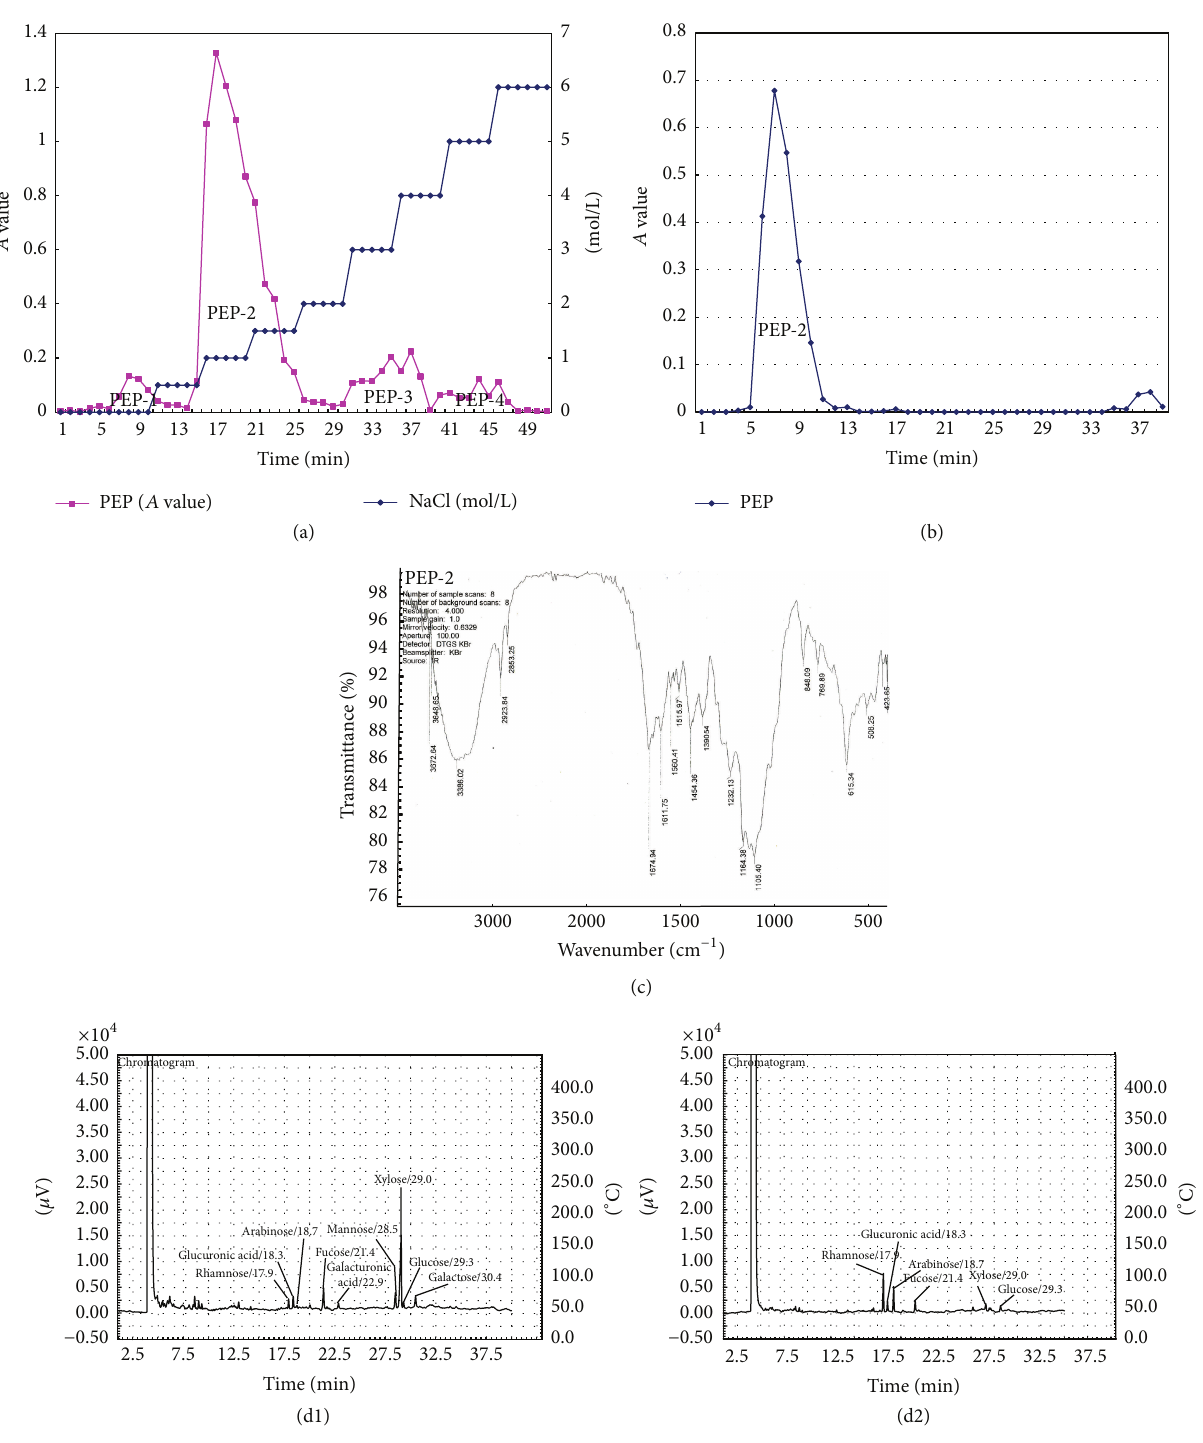
Figure 1: Characterization of polysaccharides from Enteromorpha prolifera . (a) shows four peaks in the eluting curve, PEP-1, PEP-2, PEP-3, and PEP-4. The peak area of PEP-2 is the largest and contains 161mg of polysaccharides. (b) shows the basic graph of PEP-2, which has a single, symmetrical elution peak. (c) shows the wavenumbers of 3386.02 cm −1 as the stretching vibration of O – H, 2923.84 cm −1 , 2853.28 cm −1 , and 1454.36 cm −1 as the vibration of – CH2 – . The 1390.54 cm −1 and 1232.13 cm −1 symmetric stretching vibrations corresponded to two S=O groups of sulfate groups. Furthermore, 848.09 cm −1 and 769.89 cm −1 are the antisymmetric and symmetric stretching vibrations of the sulfate groups C – O and S – O. (d1) shows that the chromatogram of different standard monosaccharides. (d2) shows that PEP-2 is mainly composed of rhamnose, glucuronic acid, arabinose, fucose, xylose, and